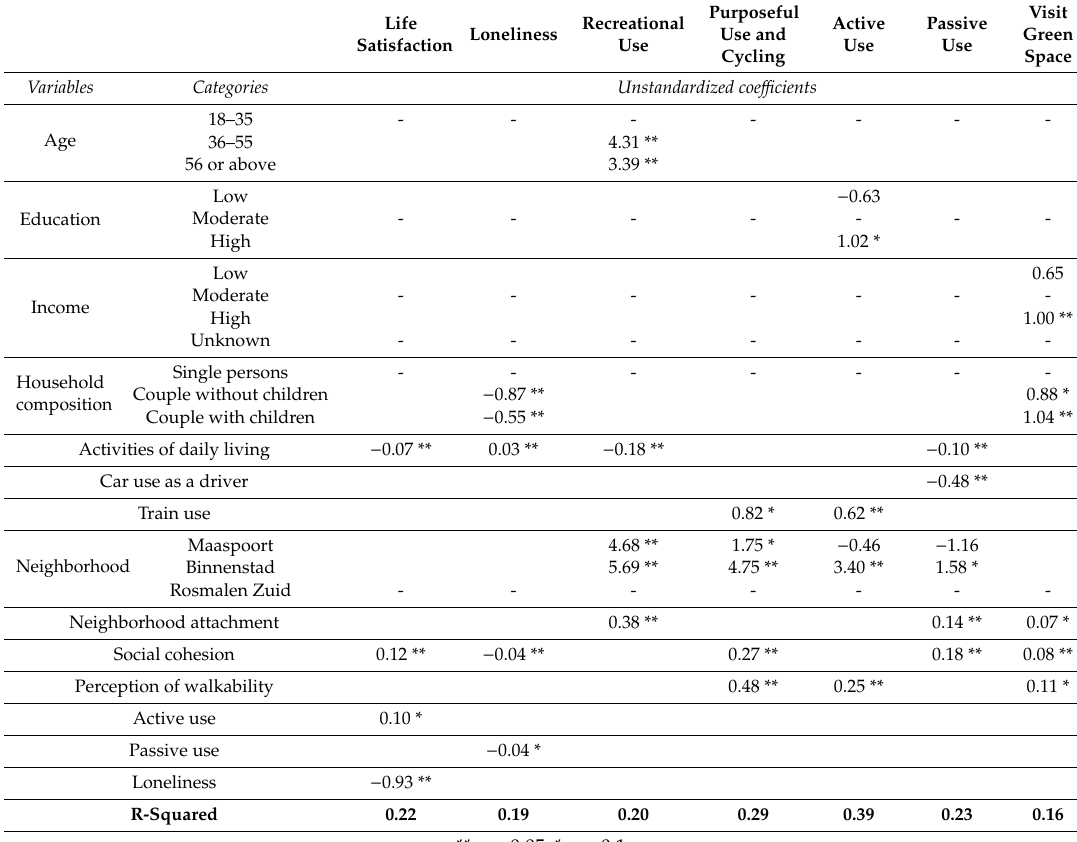
Table 5. Results path model (unstandardized coe ffi